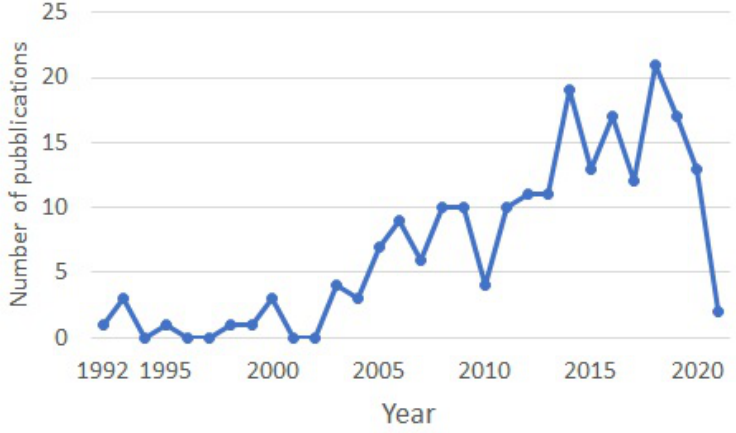
Figure 2. Evolution of the number of publications on dynamic toll pricing.